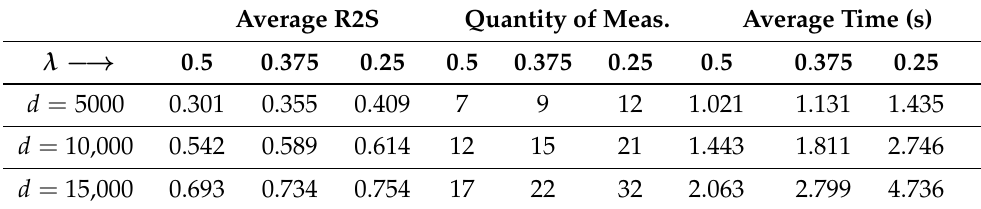
Figure 7. Progress of the proposed method using different values of λ . Table 4. Values of average R2S, quantity of measurements and time for different distances using different λ ratios. R2S is always better for λ = 0.25, while quantity of measures and computational time is better with λ = 0.5. λ = 0.375 presents a good balance of these